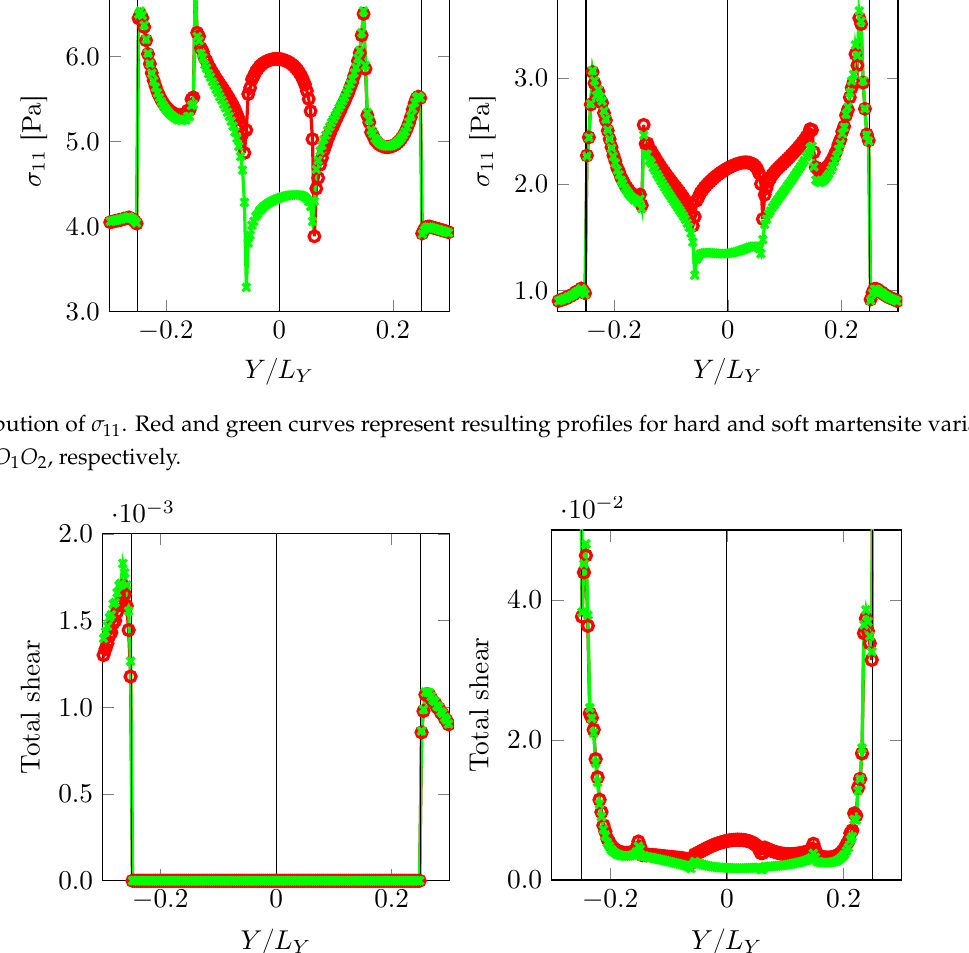
L X /2 N X close to PAGB (separating the −